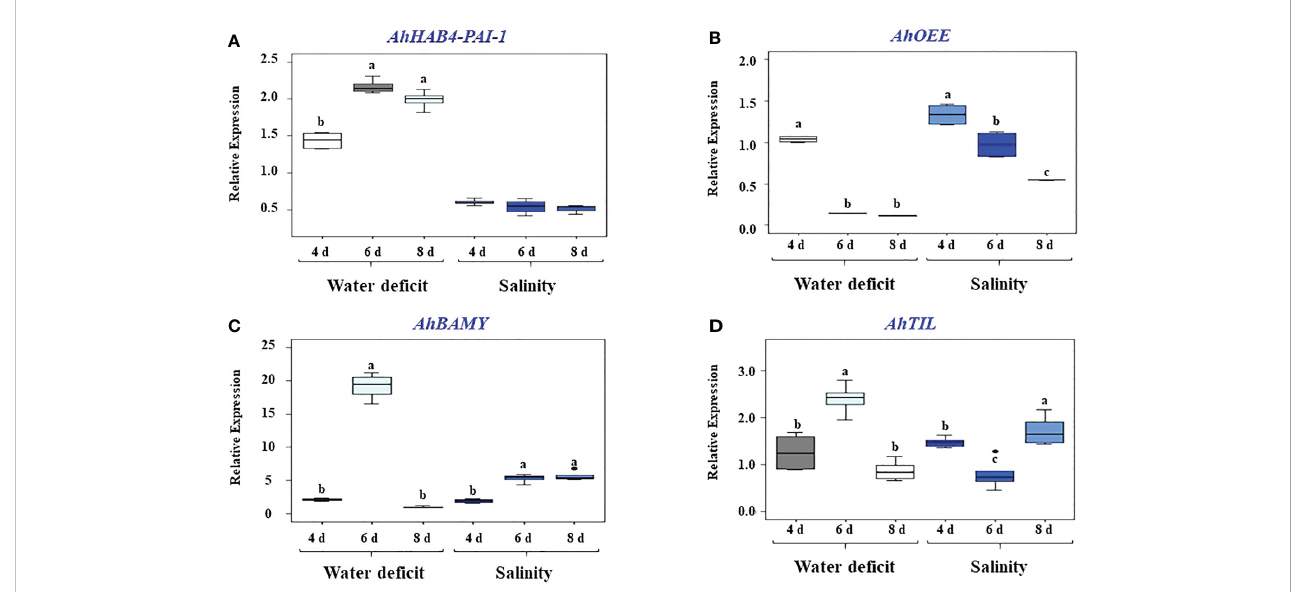
FIGURE 1 Effect of high salt and water-de fi cit stress on the expression levels of four grain amaranth unknown function genes. Relative gene expression was quanti fi ed in leaves of grain amaranth plants subjected to high salt or water de fi cit stress for 4, 6 and 8 days, respectively. The three recognized grain amaranth species were analyzed: Amaranthus hypochondriacus cv. Revancha , A cruentus cv. Dorada and A caudatus . Foliar RNA was employed for the qRT-PCR analysis of presumably stress-inducible unknown function genes, namely: (A) AhHAB4-PAI-1 ; (B) AhOEE; (C) AhBAMY , and (D) AhTIL . Threshold cycles (C T ) values for all genes were normalized to the C T value of the AhACT7 and AhEF1a housekeeping genes. Changes in gene expression were calculated from 4 technical replicates of pools prepared from 10-to-12 plants sampled per time point using the 2 - DD CT method (Livak and Schmittgen, 2001). Different letters over the box-and-whisker plots, showing high, low, and median values, represent statistically signi fi cant differences; one-way ANOVA and Tukey Kramer test , P <